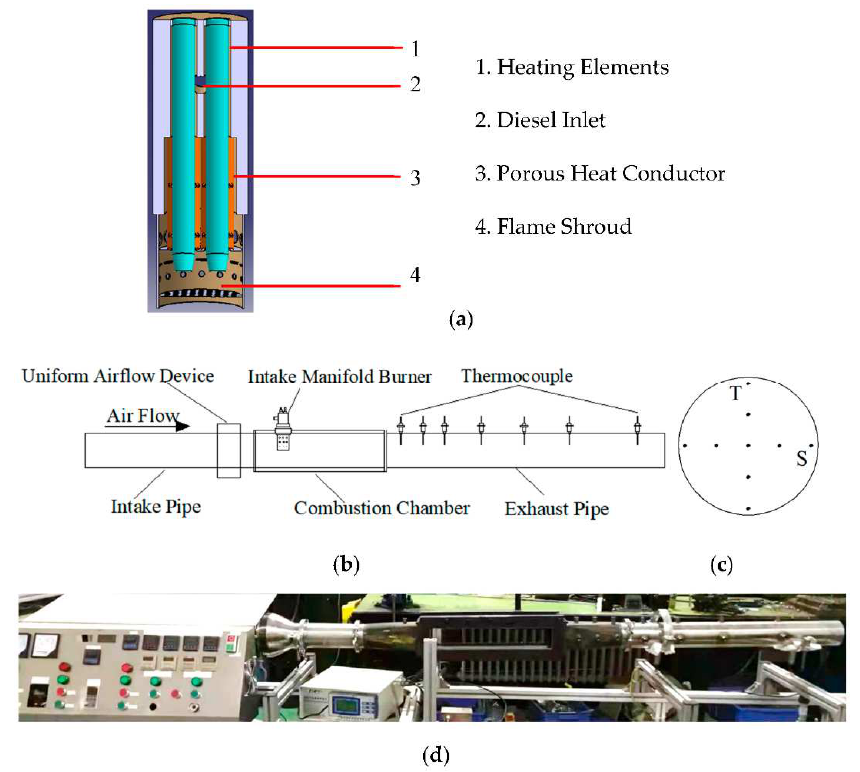
Figure 1. Schematic diagram of ( a ) the intake manifold burner, ( b ) the test system, and ( c ) the temperature measuring points in the cross-section of the exhaust pipe. ( d ) Photo of the test system. The preheat system consisted of an intake pipe, intake manifold burner, combustion chamber, and exhaust pipe, as shown in Figure 1b. A powerful fan was used as the power